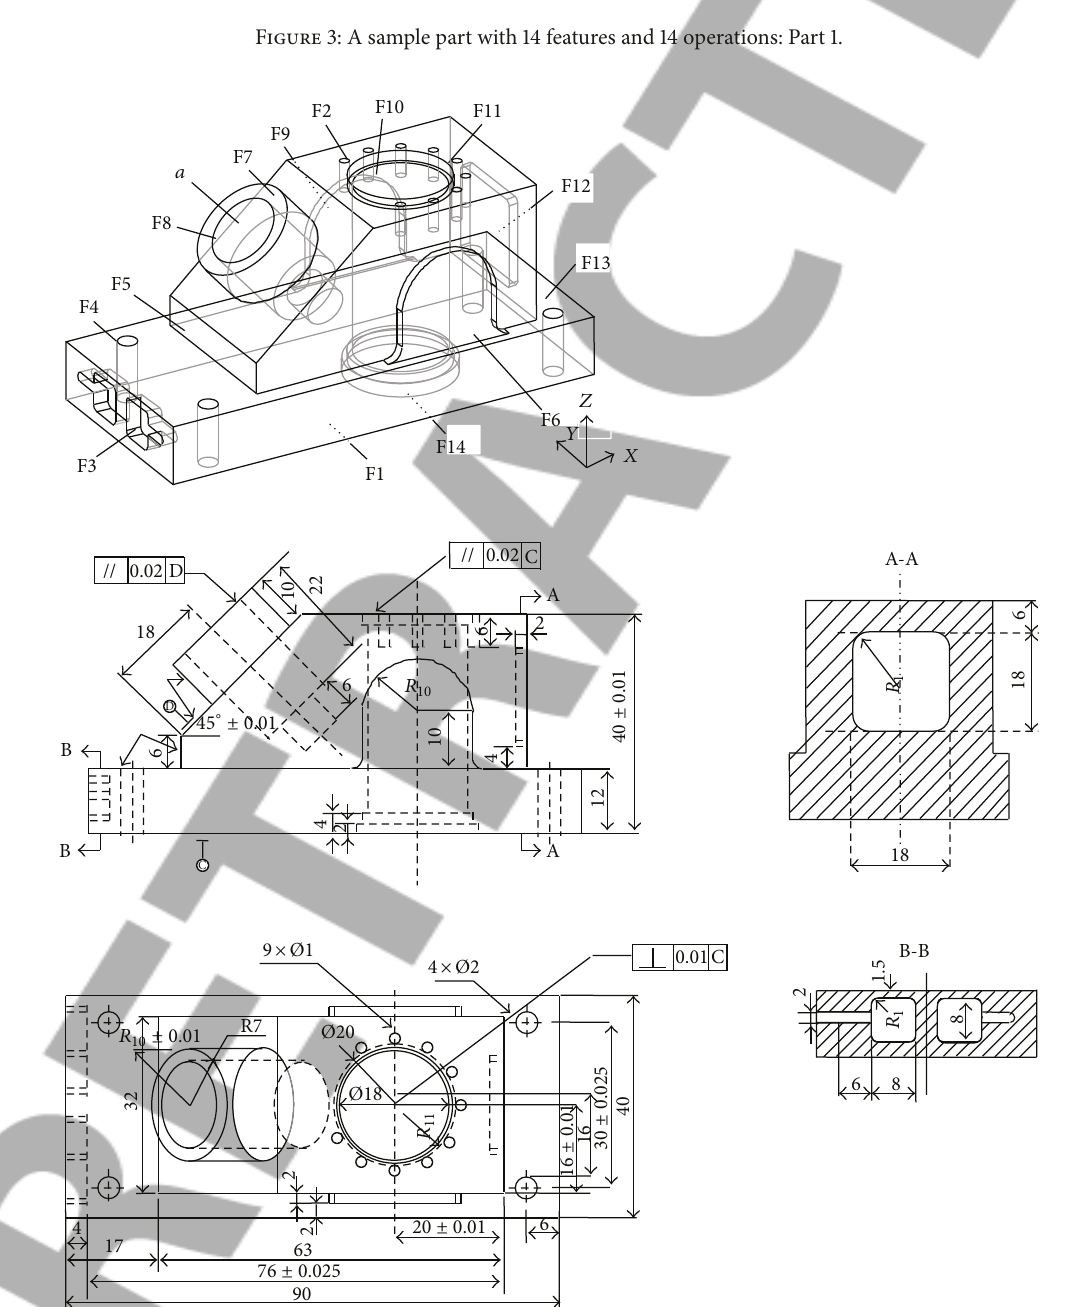
Figure 4: A sample part with 14 features and 20 operations: Part